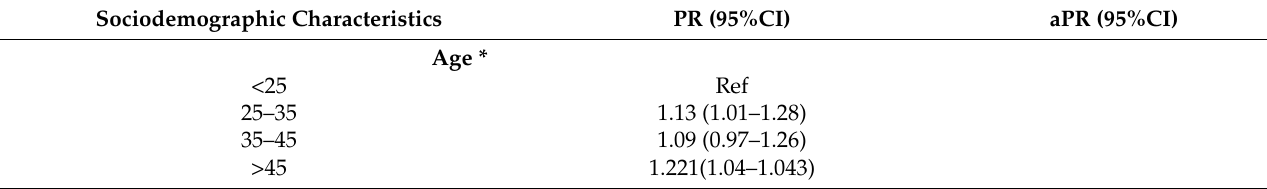
Table 2. Predictors of women’s